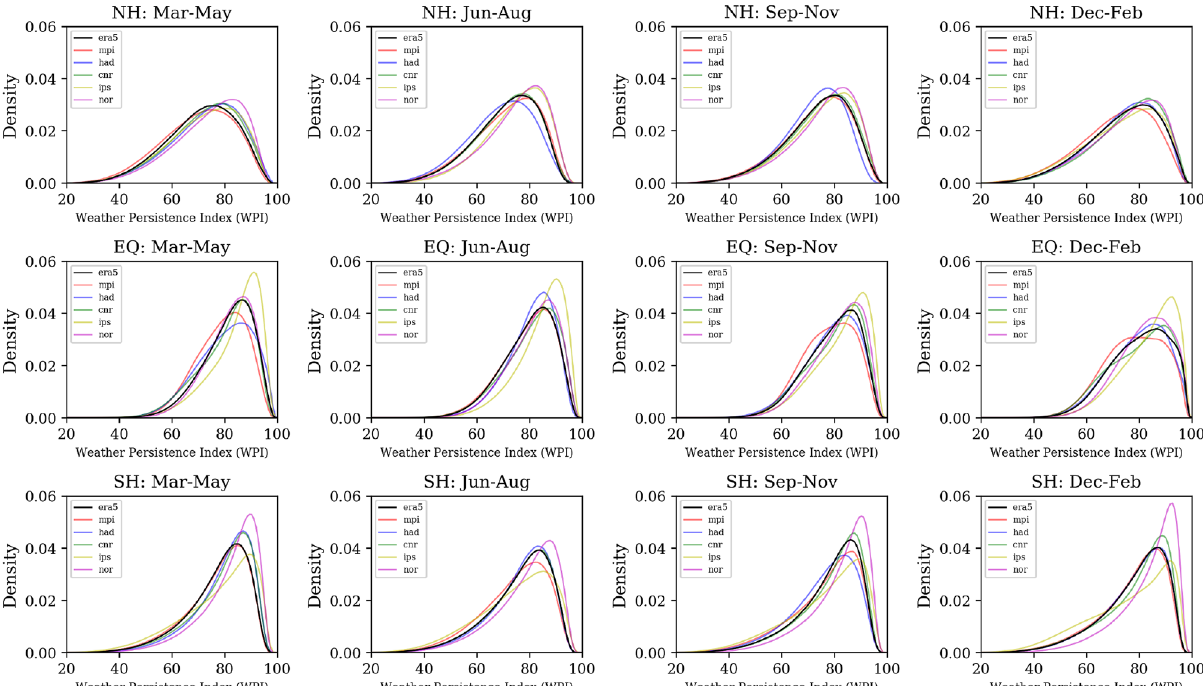
Figure 8. 1981–2019 probability density functions of the weather persistent index (WPI): seasonal (columns), hemisphere (rows), ERA5 (black line) and CMIP5 (color lines). The following abbreviations stand for: NH ◦ ◦ ◦ (75–30 N), EQ (30–30 S) and SH (30–75 S). The plots were created by using python3-matplotlib (version 3.1.2, https:// matpl otlib. org/).